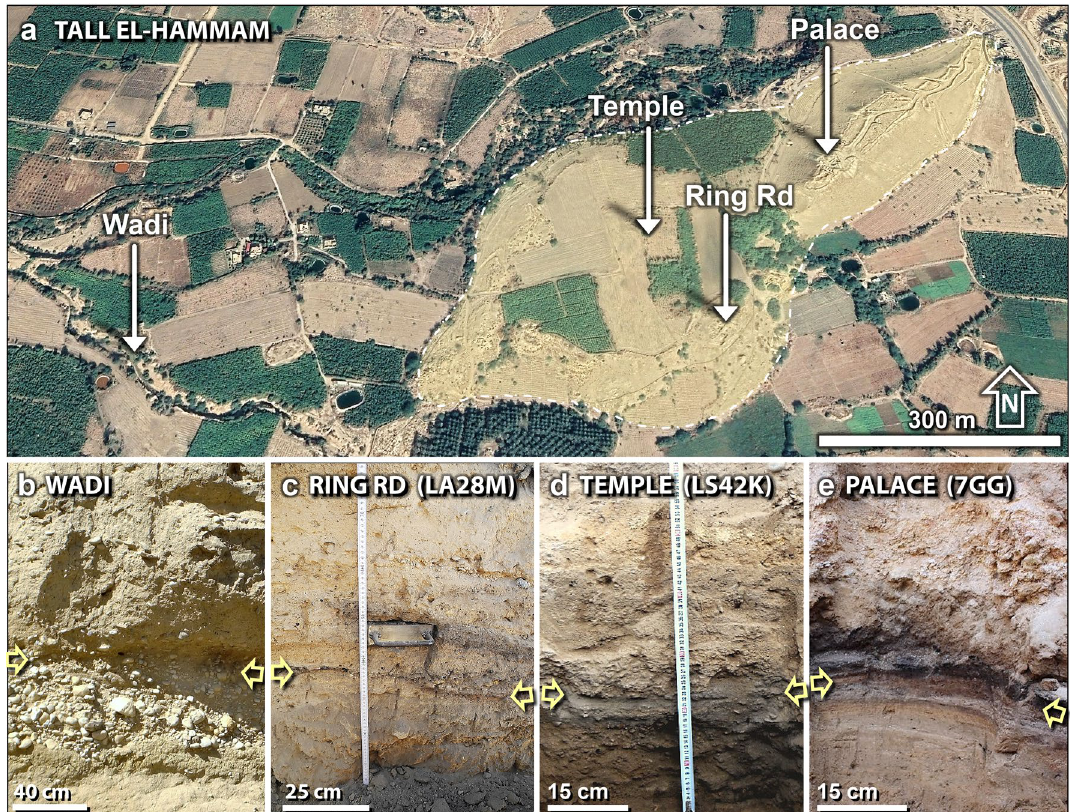
Figure 4. Sedimentary profiles. ( a ) Map of the city (white dashing line) showing sampling locations, spanning ~ 1100 m. Source of base image: “Tall el-Hammam”. 31° 50.483 N, 35° 40.029 E. Google Earth; CNES/ Airbus. Imagery date: 11/26/2019; accessed: 4/4/2021. ( b ) The wadi; ( c ) the ring road in Field LA; ( d ) the palace in Field LS; and ( e ) the palace in Field UA. In the wadi, yellow arrows mark the level of the 3600-year-old stratum. Inside the city, the arrows mark the location of the charcoal-and-ash-rich dark